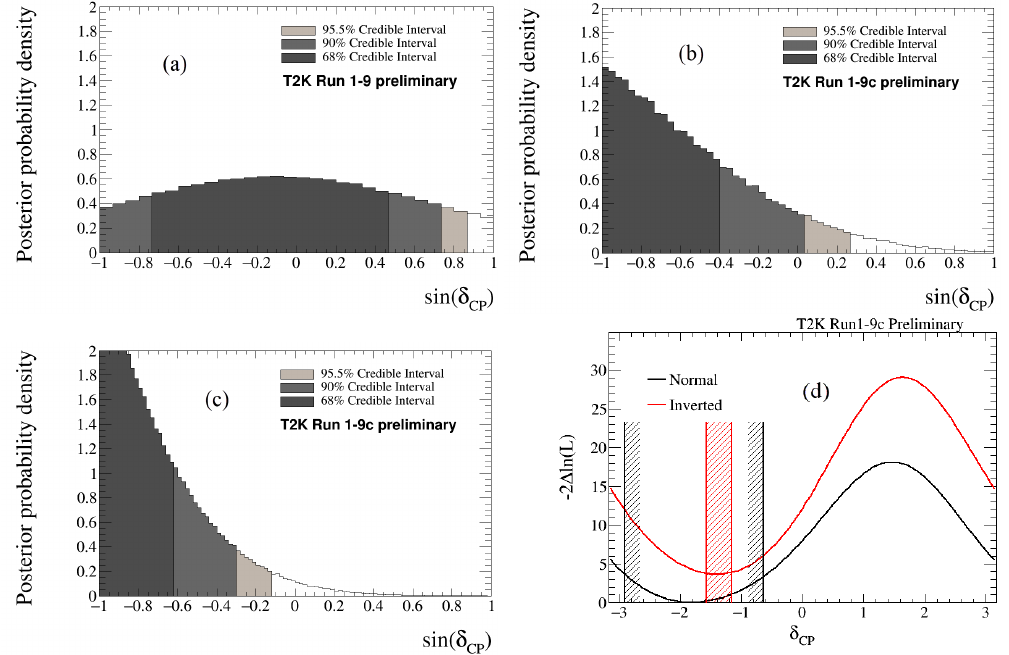
Figure 7. The posterior probability density for sin δ CP marginalized over all other parameters including mass ordering ( a – c ). The shaded regions show 68%, 90%, and 95.5% credible intervals. ( a ) The outcome for an experiment observing the expected number of events for (sin 2 θ 23 = 0.45, δ CP = 0, normal ordering). The posterior odds is 1:1 (not favoring either mass ordering); ( b ) The outcome for an experiment observing the expected number of events for (sin 2 θ 23 = 0.53, δ CP = − π /2, normal ordering). The posterior odds are 2.7 in favor of normal ordering; ( c ) The outcome for the T2K observation. The posterior odds are 7.9 in favor of normal ordering and sin δ CP = 0 is outside of the 95.5% credible interval; ( d ) The frequentist 2 σ confidence intervals on δ CP (selected using the likelihood ratio) shown separately for the two mass